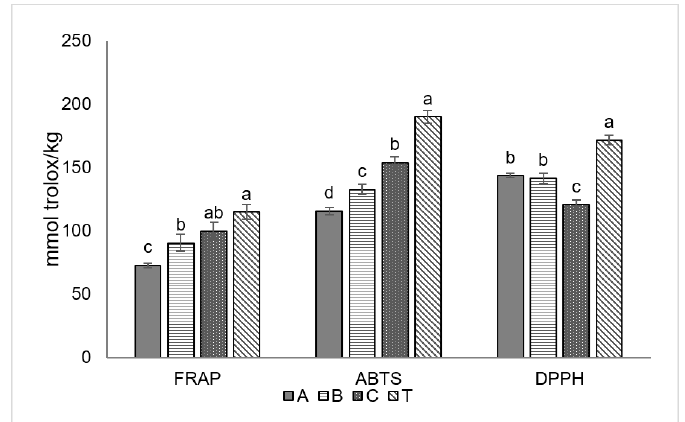
Figure 2. Antioxidant activity (FRAP, ABTS, and DPPH) of olive drupe treated with three biostimulants: A (tropical plants extract), B (glycine betaine), and T ( Trichoderma ) all compared with C (control). Values are mean ± standard error and different letters indicate significant differences based on Duncan’s test ( p = 0.05).